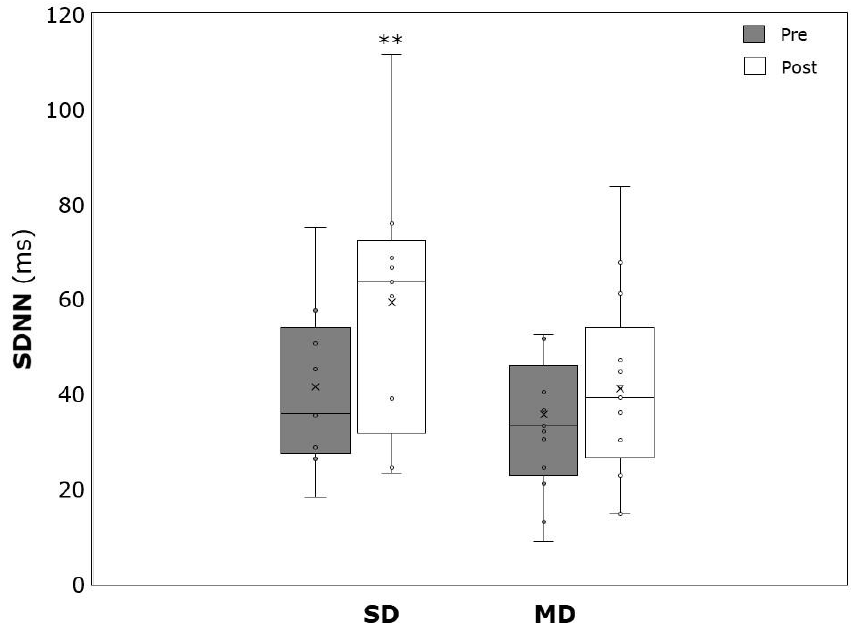
Figure 9. Standard deviation of all normal-to-normal intervals before (SDNN) (pre) and after (post) the intervention period for severely depressed (SD) and mildly depressed (MD). ** p < 0.01 within- group difference.